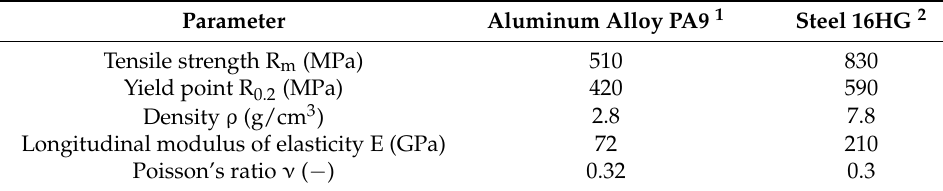
Table 1. Material properties.